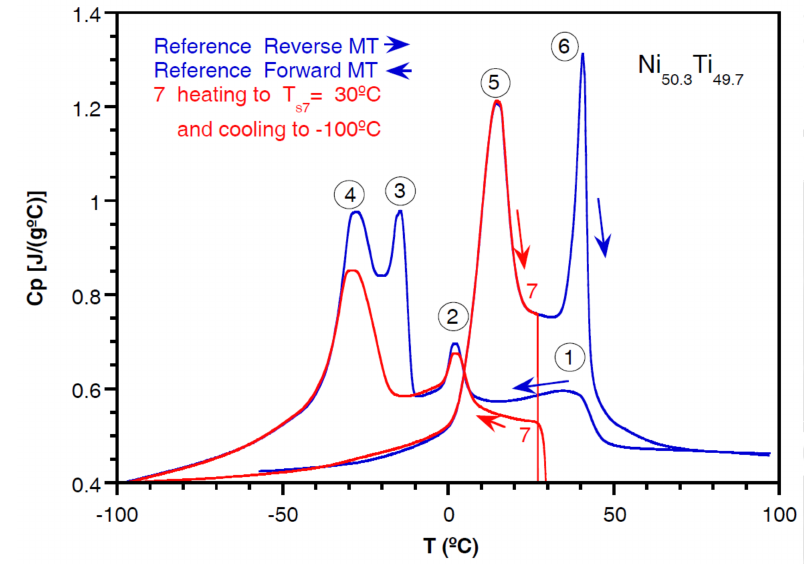
Figure 4. Partial cycling of Ni 50.3 Ti 49.7 from − 100 ◦ C to 30 ◦ C and then to − 100 ◦ C to complete the study of the multistage MT. The obtained C p curve (red) is compared with the complete forward and reverse MTs between − 100 ◦ C and +100 ◦ C (in blue).